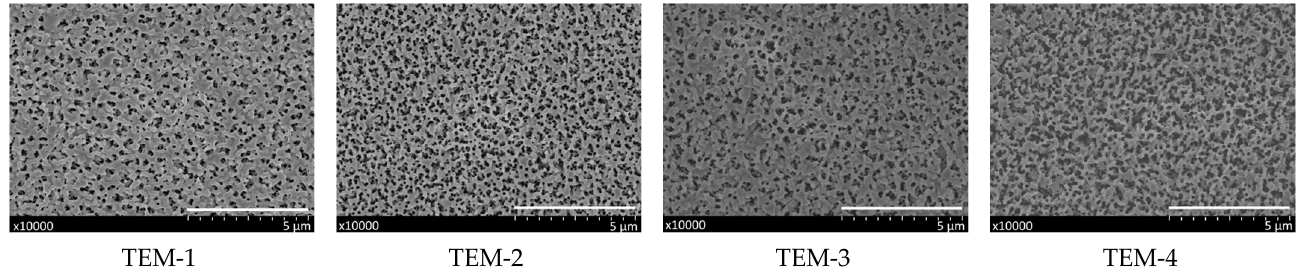
Figure 3. SEM images ( top ) and pore size distributions ( bottom ) of side a of membranes TEM-1, TEM-2, TEM-3 and TEM-4 (from the left to the right). Scale bar, 0.5 μ m.